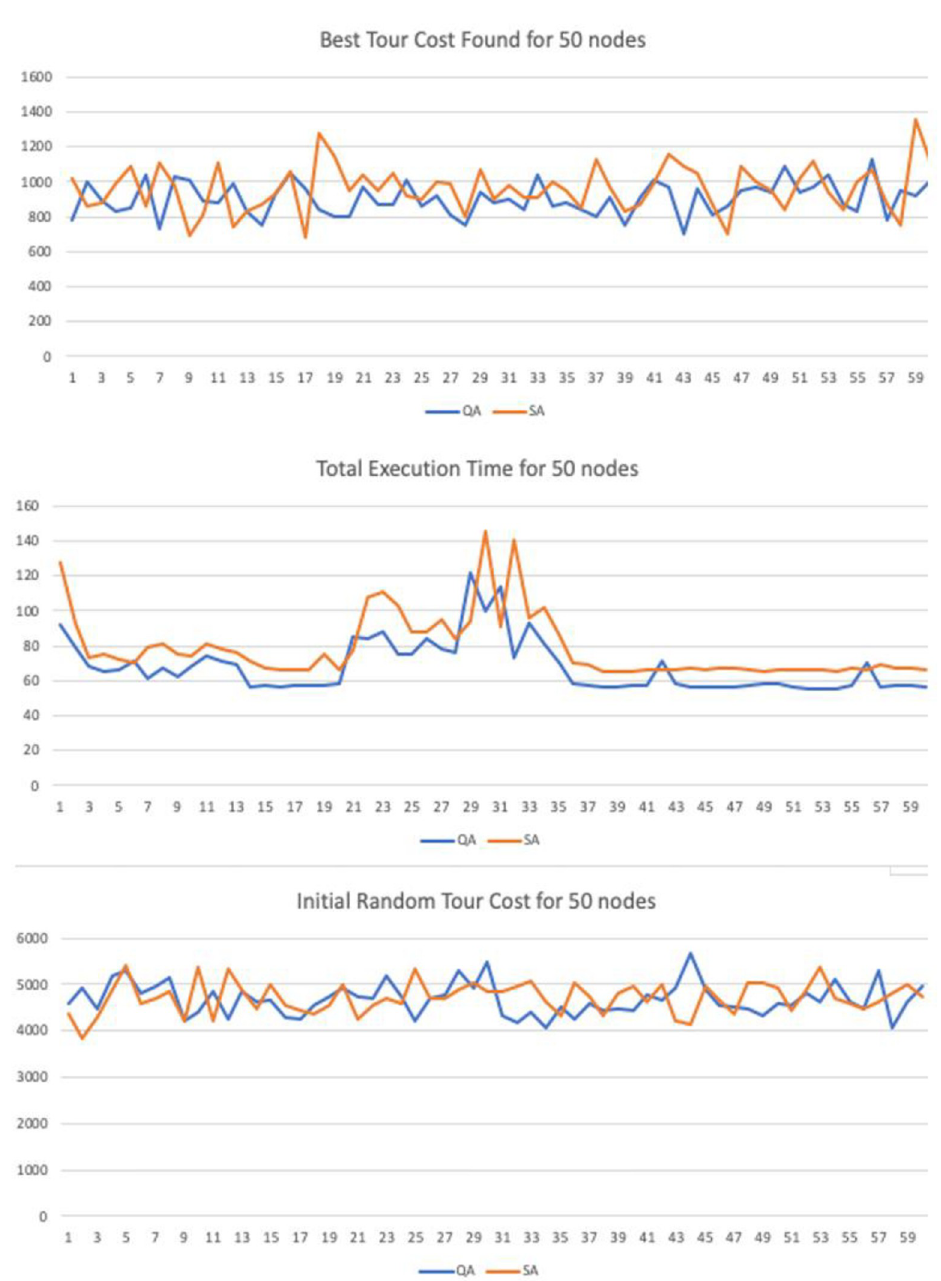
Fig 40. Chart with results for test cases with n = 50 nodes with sample size N =